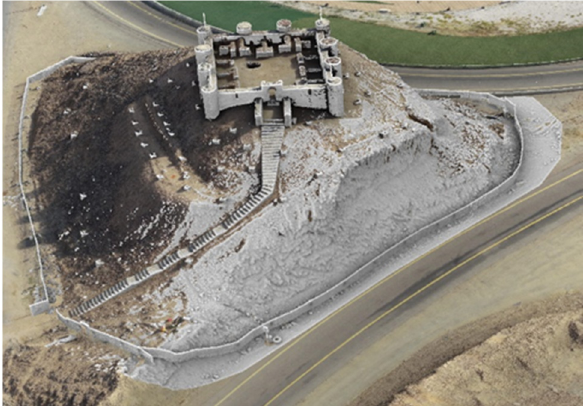
Figure 17. Data fusion of the UAV 3D textured model with the TLS point cloud (shaded).